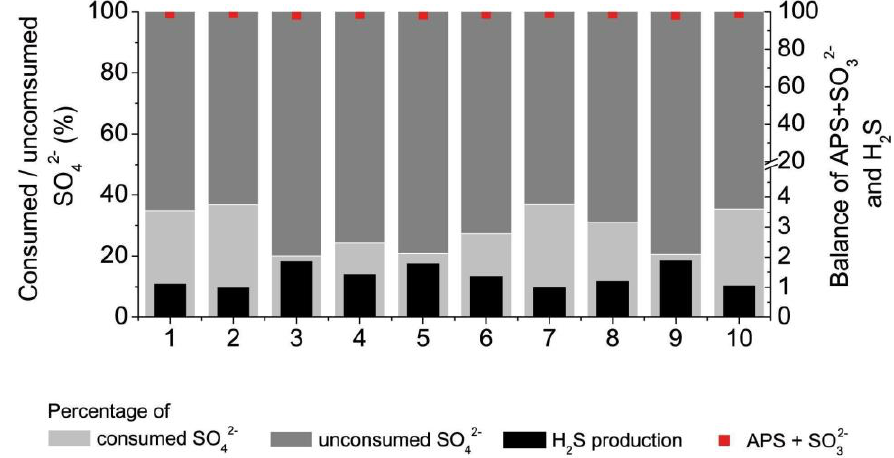
Figure 4. Balance of sulfate consumption, H 2 S production and APS/sulfite accumulation by collected stains of SRB within the first 24 h. stains of SRB within the first 24 h.